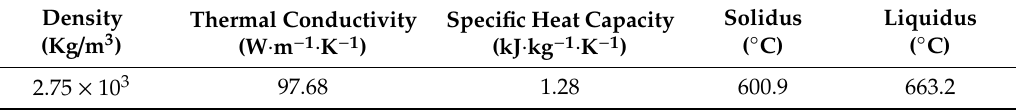
Figure 3. Simplified model ( a ), surface mesh ( b ), and solid mesh ( c ). Table 2. Thermophysical parameters of the 7075 Al alloy.